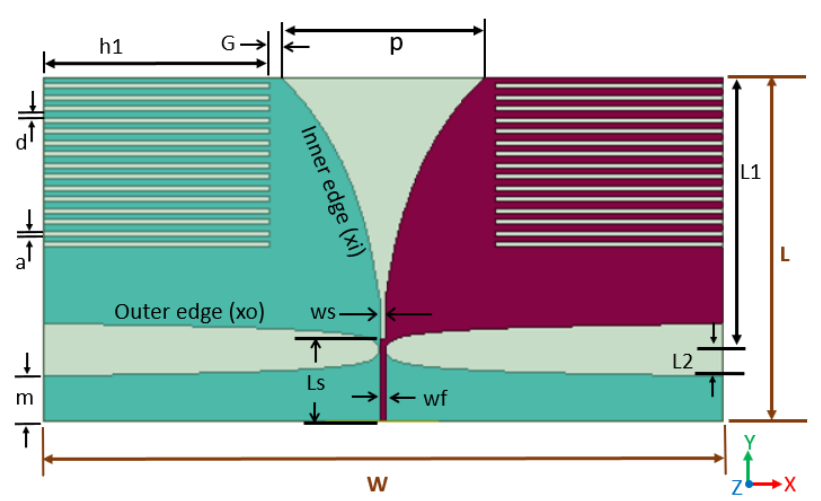
Figure 12. Proposed antenna 2 (top view). Parameters: L = 30.32 mm, W = 60 mm, a = d = 0.5 mm, h1 = 20 mm, L1 = 24 mm, L2 = 2.32 mm, p = 18 mm, wf = 0.5 mm, m = 4 mm, ws = 0.5 mm, Ls = 7.32 mm.